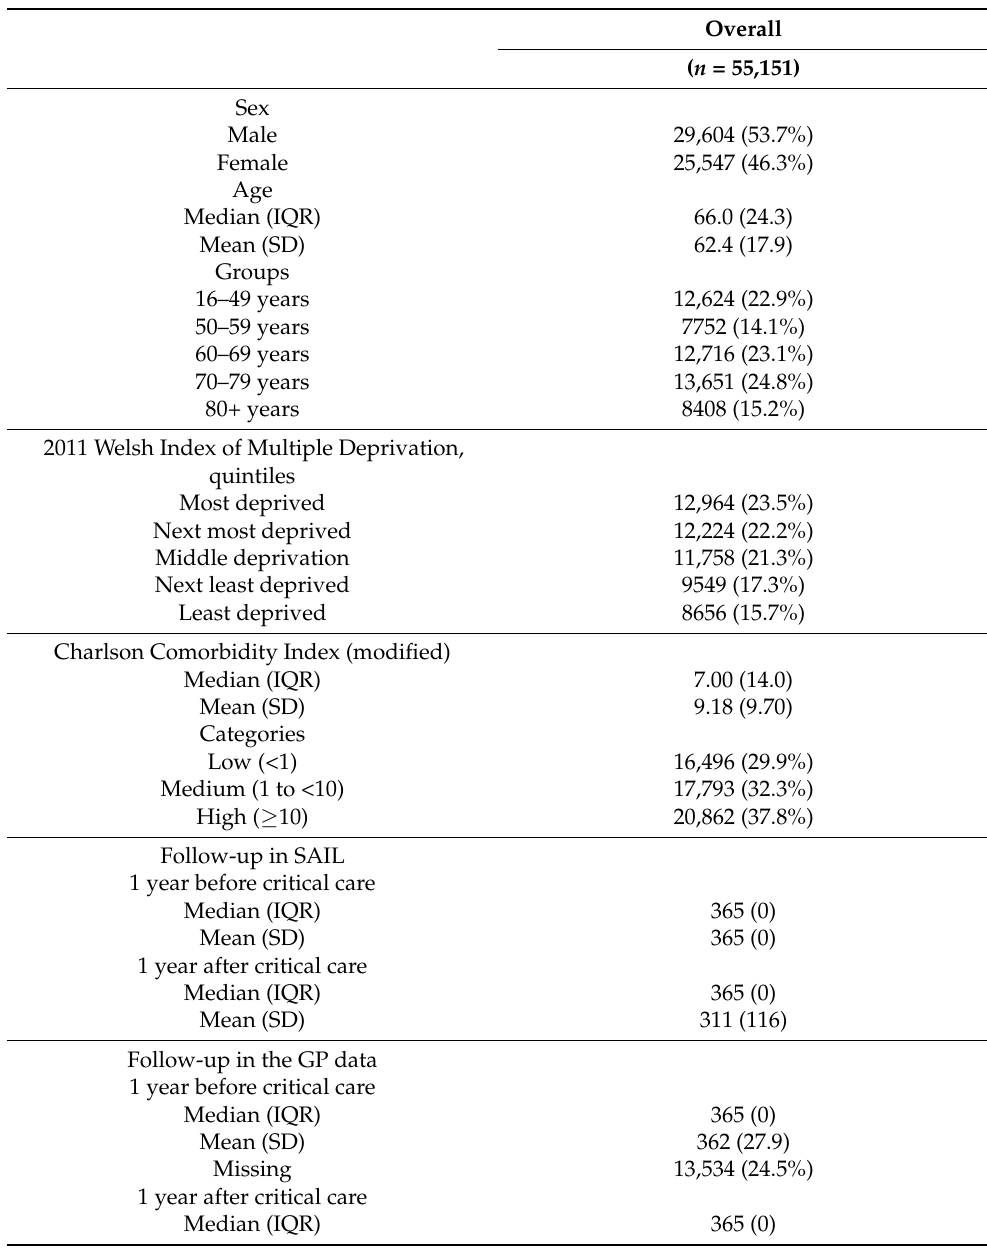
Table 1. Characteristics of the critical care